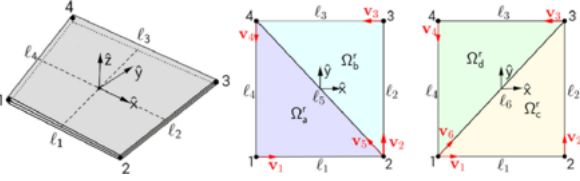
Figure 5: Definition of a quadrangular element by coupling multiple triangular elements